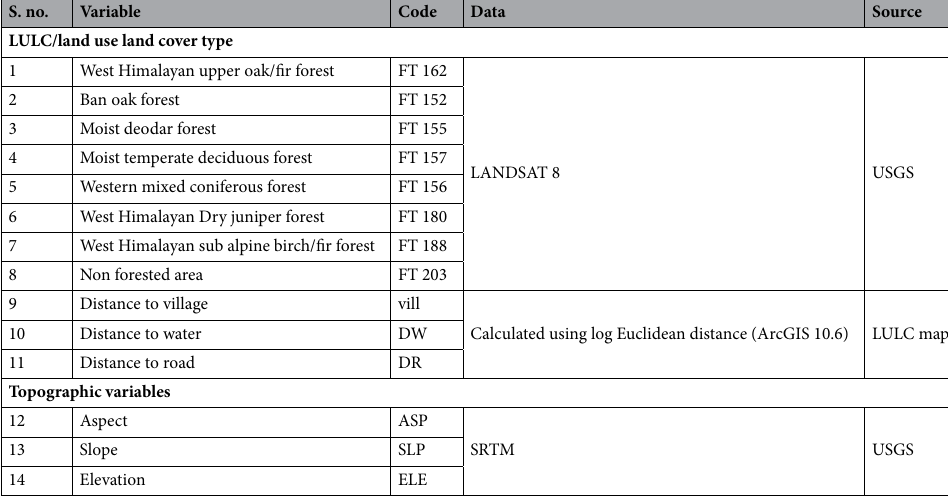
Table 3. Habitat variables used for multi species occupancy analysis of three ungulate species in Uttarkashi,